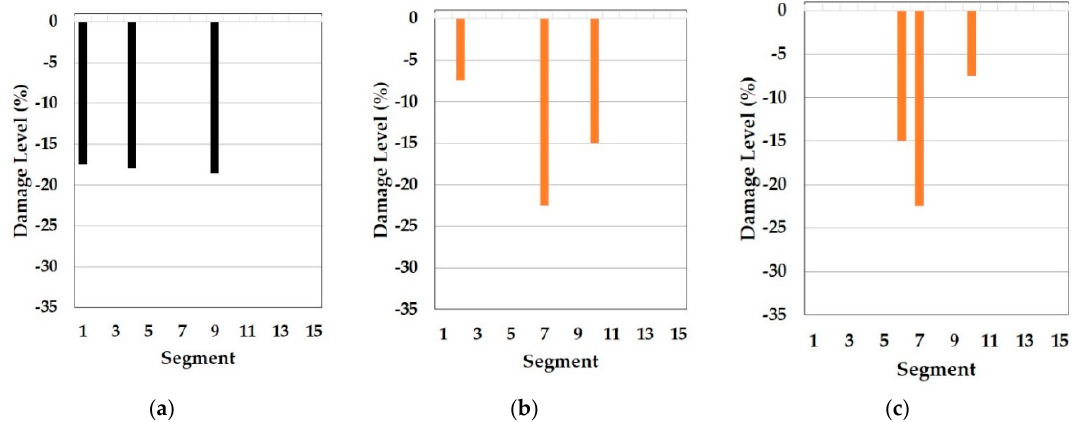
Figure 12. Symmetric baseline model under DS3 (blue color is correct segment whereas orange color is incorrect segment): ( a ) Predicted damage from the GA (black color); ( b ) top one damage case using the first to third natural frequencies; ( c ) top two damage case using the first to third natural frequencies.